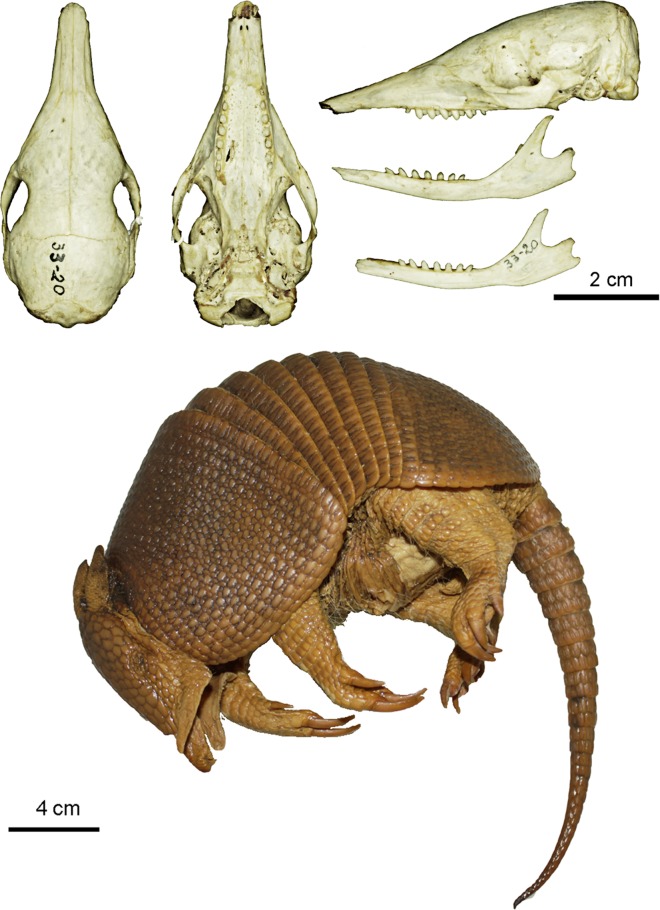
Skin, skull, and mandible of the holotype of Dasypus septemcinctus cordobensis new subspecies (MACN 33.20).